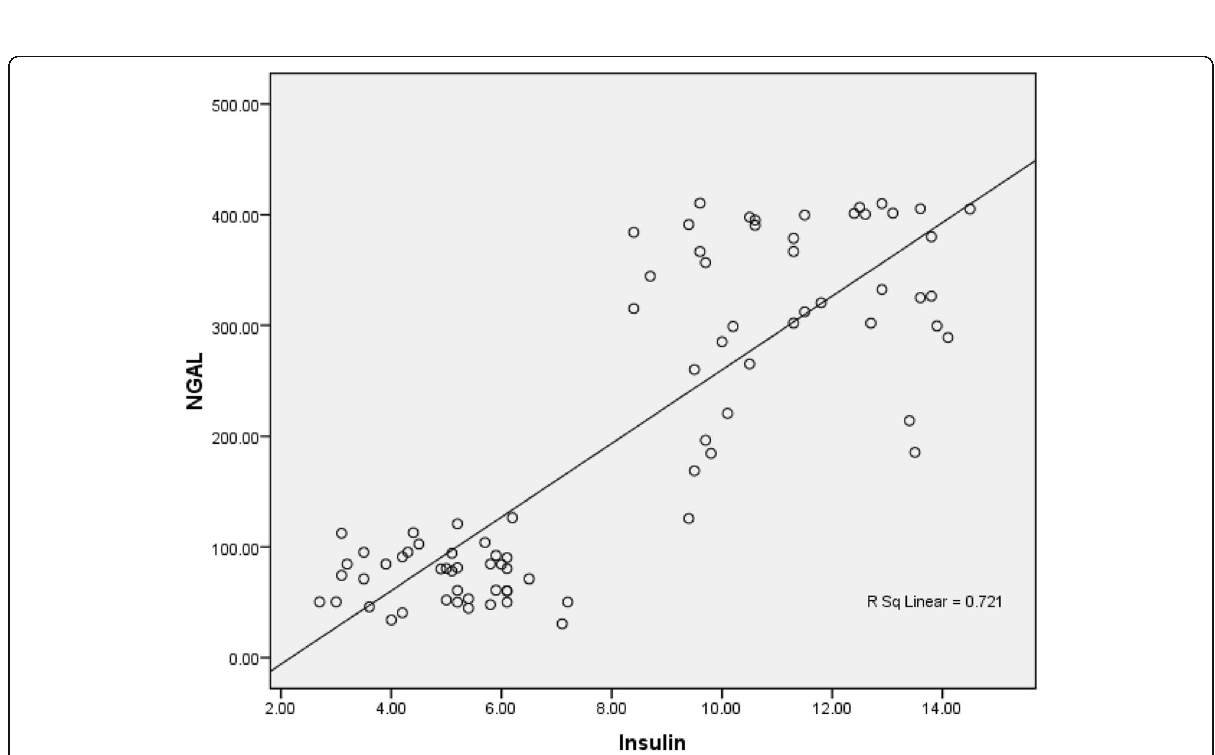
Fig. 6 Scatter diagram showing positive correlation between NGAL and